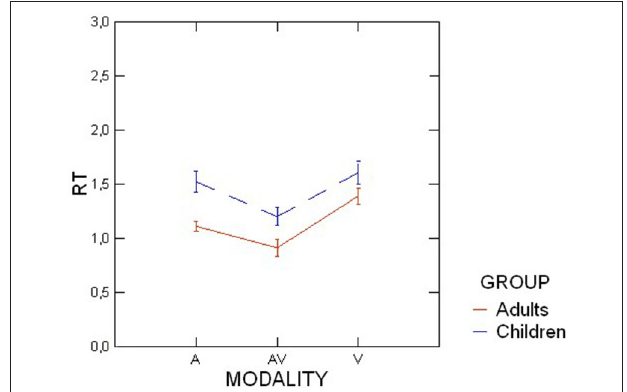
FIGURE 7 | Average values of reaction time for child and adult participants, for each modality and vowel. AV, audiovisual; A, audio; V, visual. Error bars are standard errors.